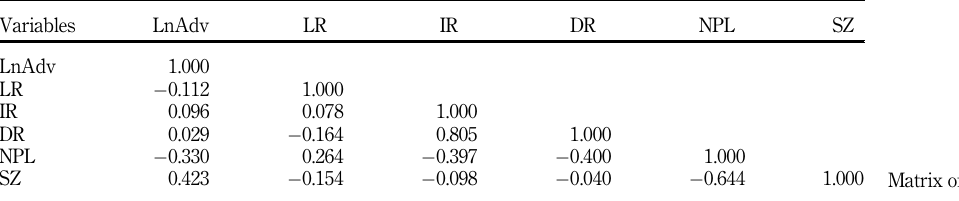
Table 2. Matrix of